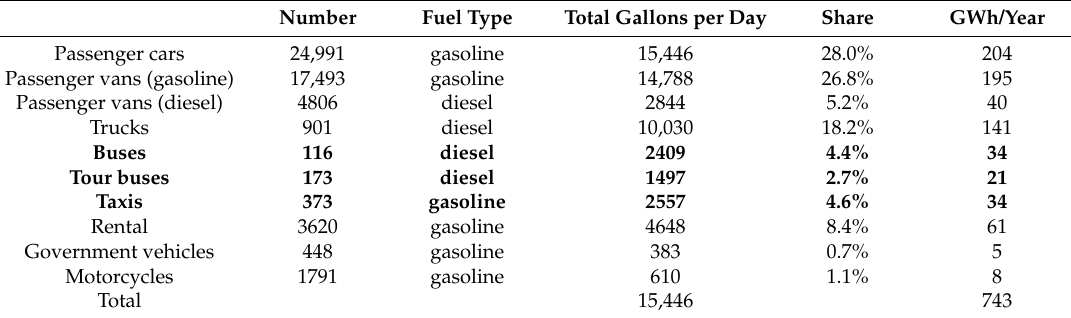
Table 3. The share of different transportation modes in a typical Caribbean island